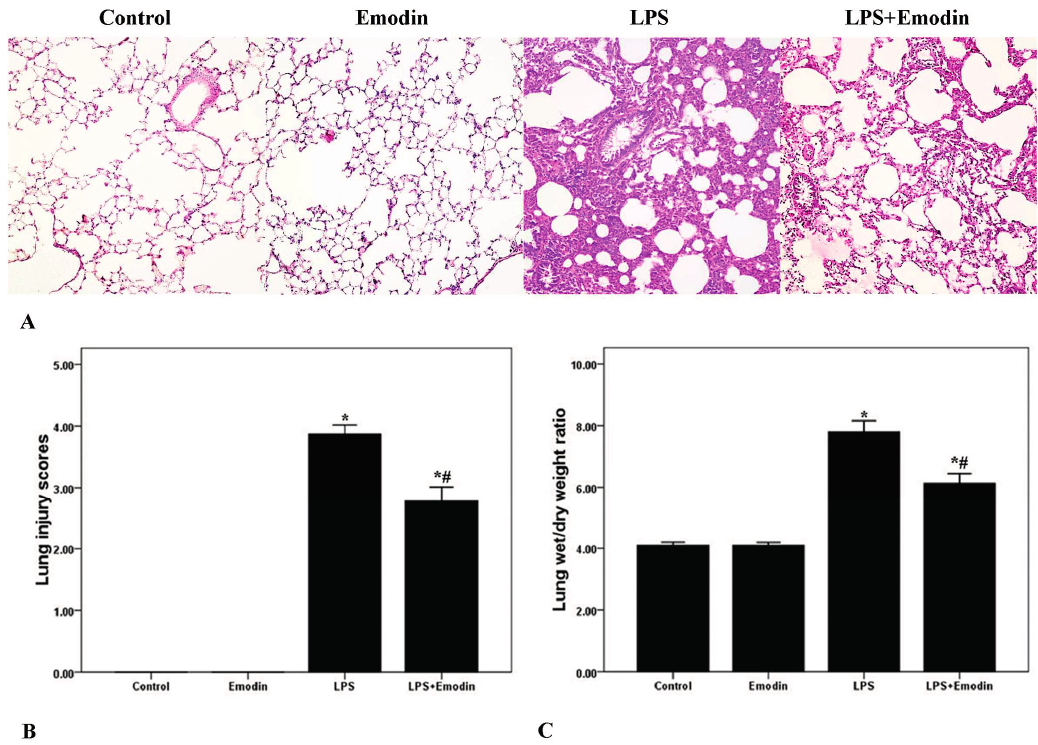
Figure 1. Emodin ameliorates pulmonary inflammation and pulmonary edema in lipopolysaccharide (LPS)-induced acute lung injury (ALI). ( A ) After 72 h interventions, mice were sacrificed and their right lower lungs were fixed. Then, tissue sections were stained with hematoxylin and eosin (H&E). The figure demonstrates a representative view (×200) from each group; ( B ) Severity of lung injury was analyzed by the lung injury scoring system; ( C ) The left lower lungs were obtained to assess wet to dry (W/D) ratio of lung. Each bar represents the mean ± SD of 10 mice. * p < 0.05 compared with Control. # p < 0.05 compared with